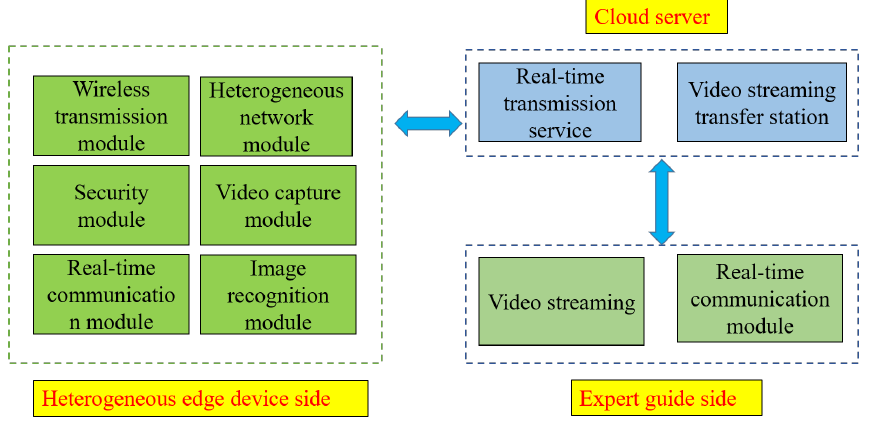
Figure 2. Main modules of the edge